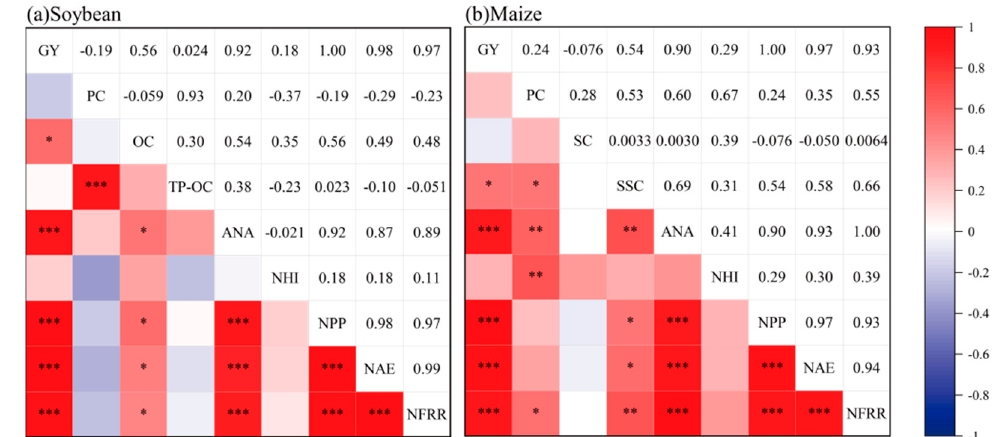
Figure 3. Correlation matrix between seed yield (SY), seed quality [soybean: protein content (PC), oil content (OC), total protein–oil content (TP-OC); maize: protein content (PC), starch content (SC), soluble sugar content (SSC)], aboveground nitrogen accumulation (ANA), nitrogen harvest index (NHI), nitrogen partial productivity (NPP), nitrogen agronomic efficiency (NAE) and nitrogen fertilizer recovery rate (NFRR) in soybean ( a ) and maize ( b ). The figures show that the correlation coefficient. * p < 0.05, ** p < 0.01, *** p < 0.001.